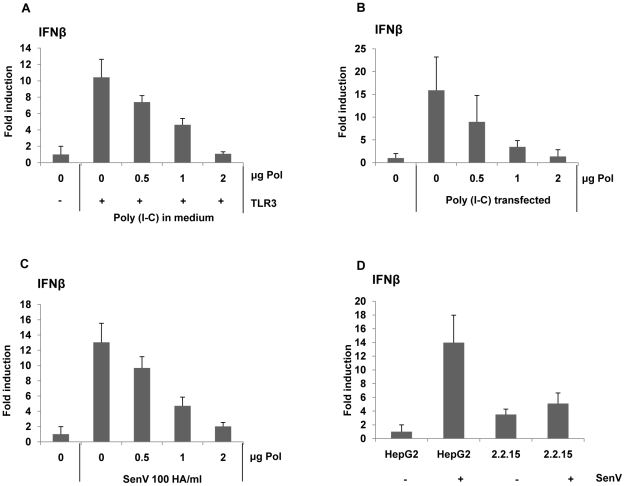
HBV Pol inhibits both dsRNA- and Sendai virus-induced IFNβ promoter activation.HepG2 cells were transfected with increasing doses of the HBV Pol expression construct, along with the IFNβ luciferase reporter construct and TLR3 expression construct. Cells were stimulated with 25 µg/mL poly I∶C directly added to the medium for 8 h (A), with 25 µg/mL poly I∶C transfected with lipofectin for 8 h (B), or with Sendai virus (SenV) 100 HA/mL for 6 h (C). Data are expressed as the mean fold induction ± s.d. relative to control levels. The results are representative of three independent experiments, each performed in triplicate. (D) Cells (HepG2 or HepG2.2.15) were transfected with an IFNβ luciferase reporter and then, infected with Sendai virus (SenV) 100 HA/mL for 6 h before harvest.